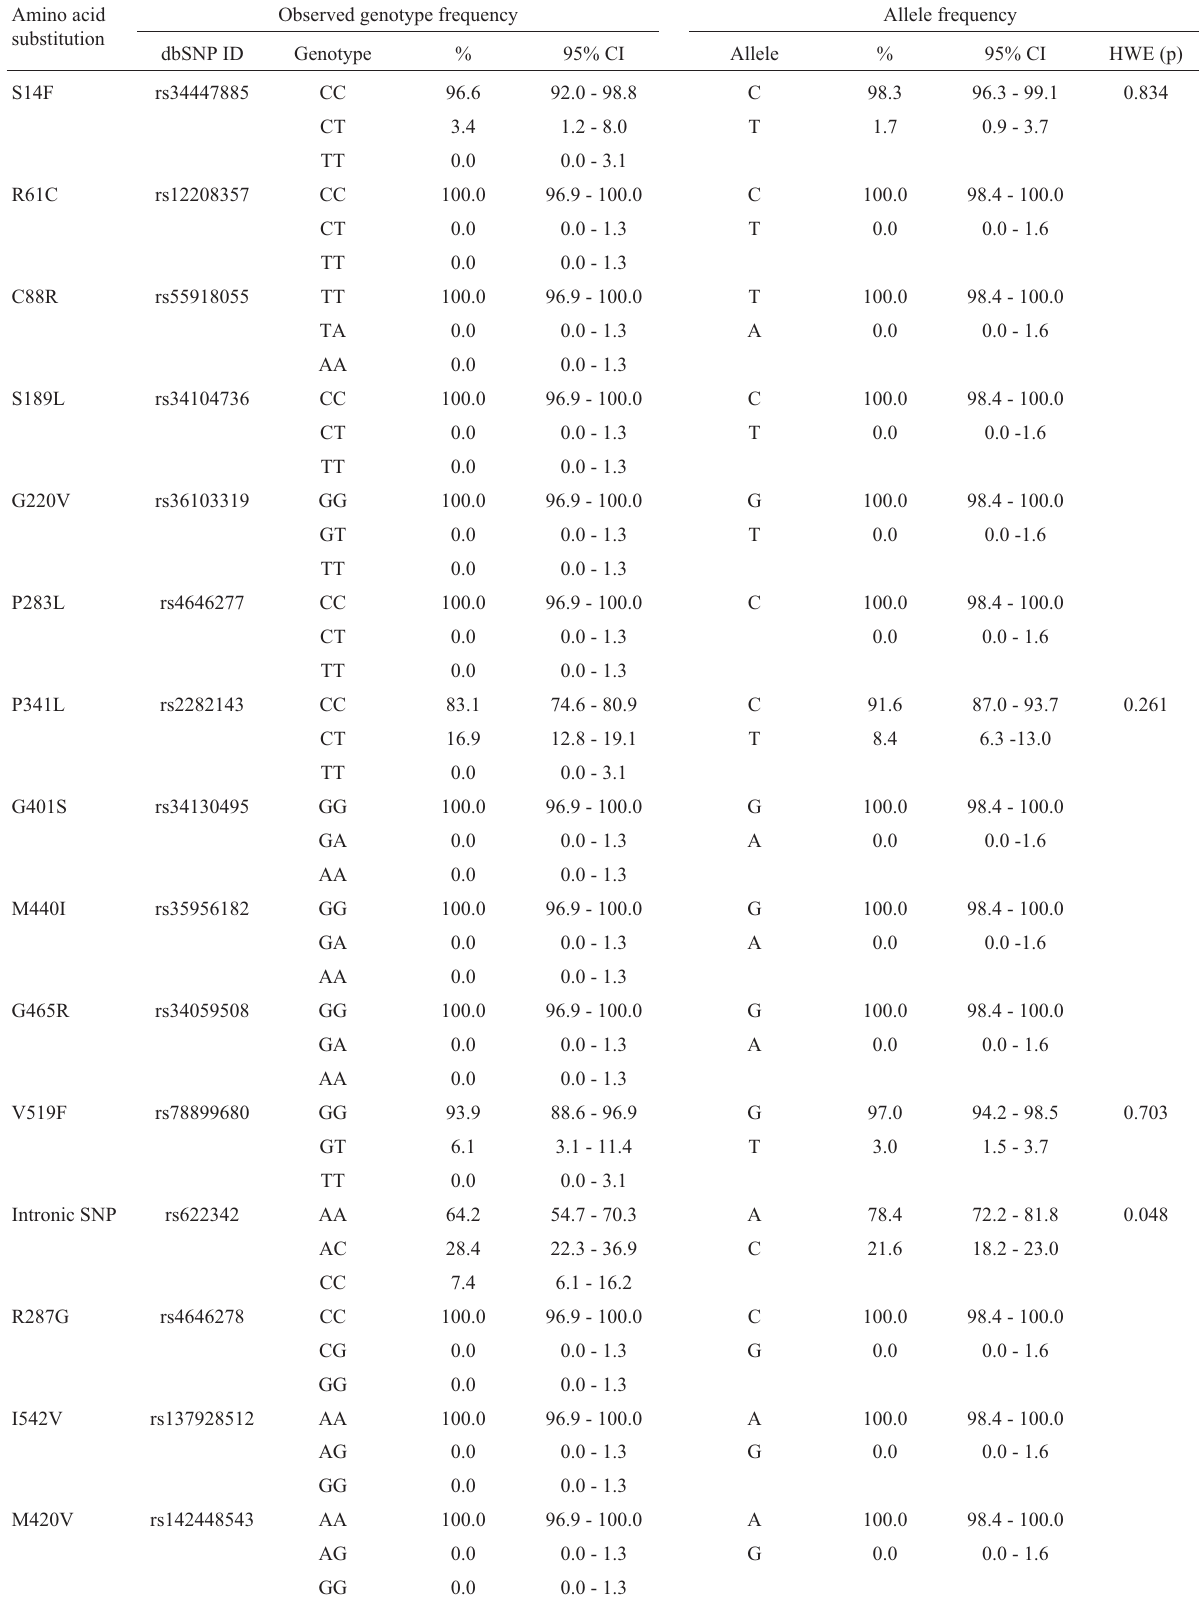
Table 4 - Genotype and allele frequencies of OCT1 ( SLC22A1 ) gene SNPs in 148 healthy Xhosa individuals. Amino acid